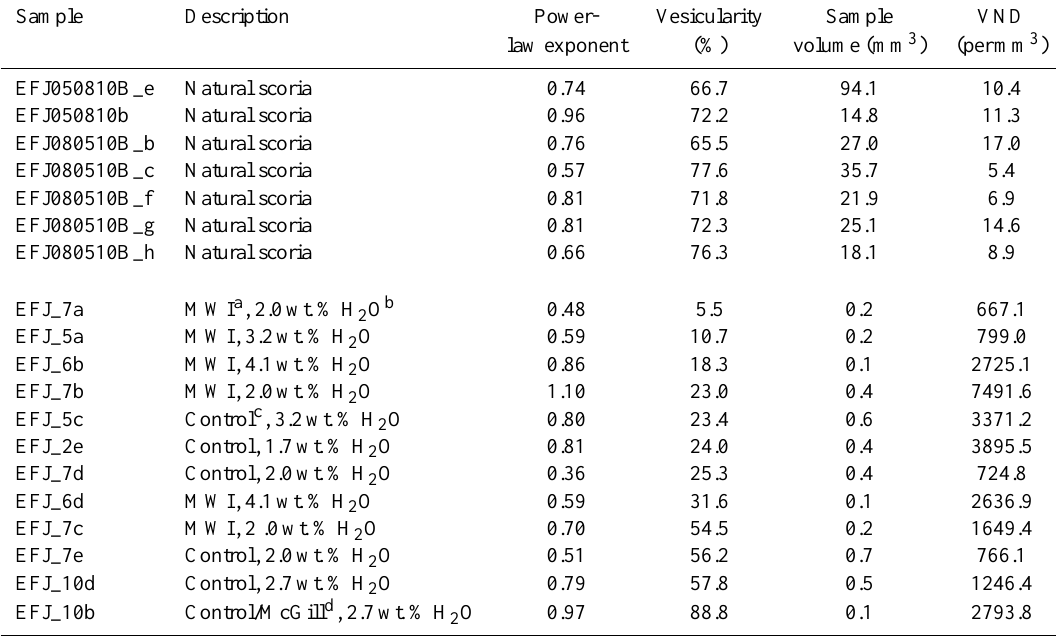
Table 1. Summary of vesicle size distributions (VSDs), vesicularity, sample volume and vesicle number density (VND).